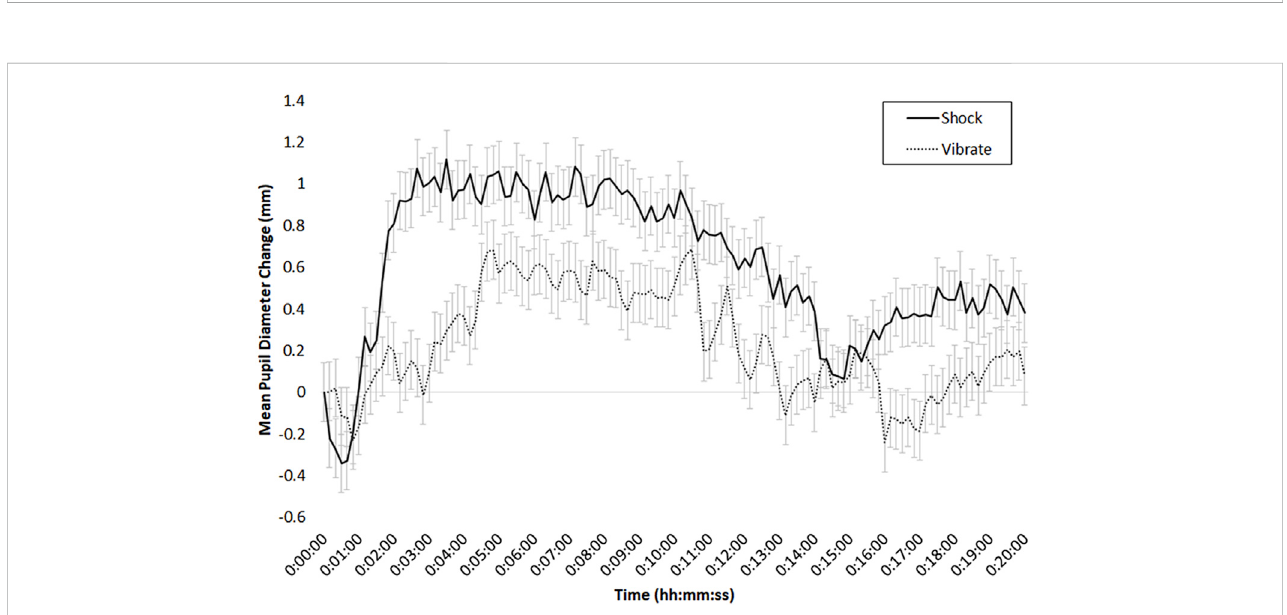
FIGURE 8 Mean change in pupil diameter (in mm), for the 20-min period of the DeMUS scenario, in the shock (solid line) and vibrate (dotted line) conditions; bars indicate standard error of the mean.